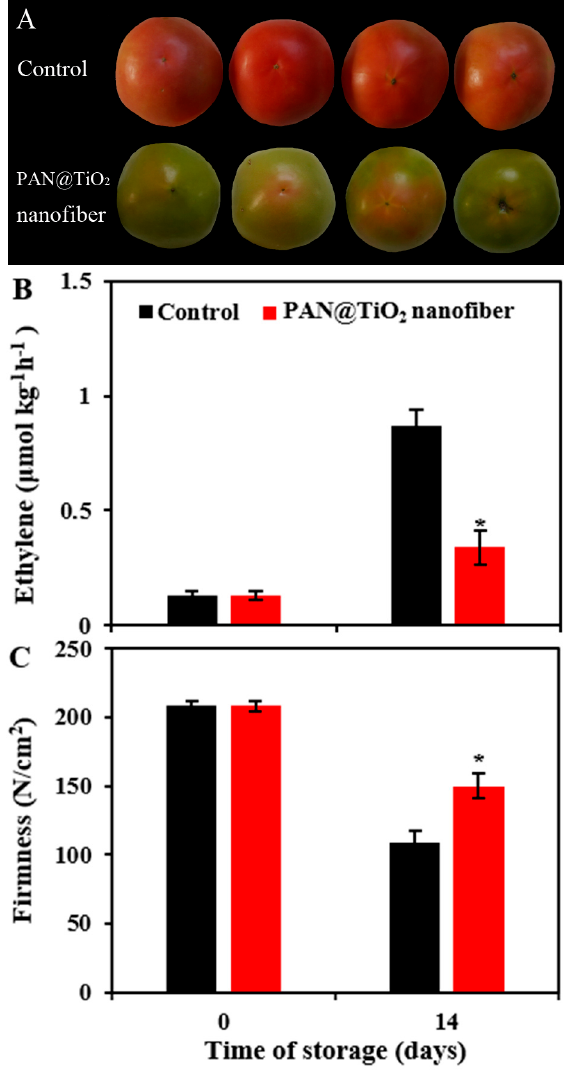
Figure 7. Photographs ( a ); ethylene production ( b ); and firmness ( c ) of tomatoes stored for 14 days covered with PP film (control) or PP film and PAN@TiO 2 nanofibers. The data represent the means of three independent experiments. The error bars indicate the standard deviation of the mean. Asterisks indicate significant differences between the control and nanofiber-covered fruit according to the Student’s t -test ( P < 0.05).